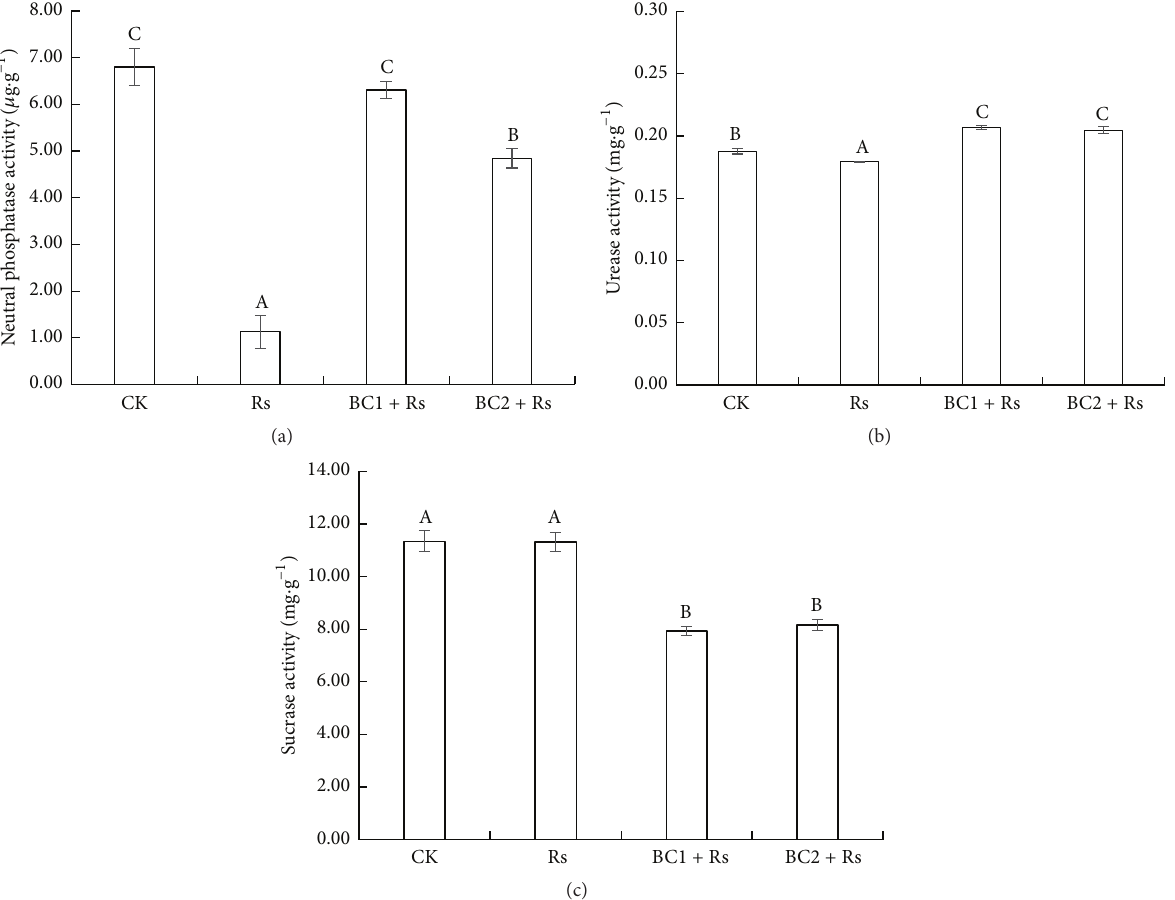
Figure 6: Effects of biochar amendment and R. solanacearum inoculation on the activity of soil neutral phosphatase (a), urease (b), and sucrase (c). CK, no biochar and no R. solanacearum inoculation; Rs, R. solanacearum inoculation; BC1 + Rs, peanut biochar amendment and R. solanacearum inoculation; BC2 + Rs, wheat biochar (BC2) amendment and R. solanacearum inoculation. Different letters on the columns denote a significant difference at 𝑃 < 0.05 using the DMRT (Duncan’s new multiple range tests)